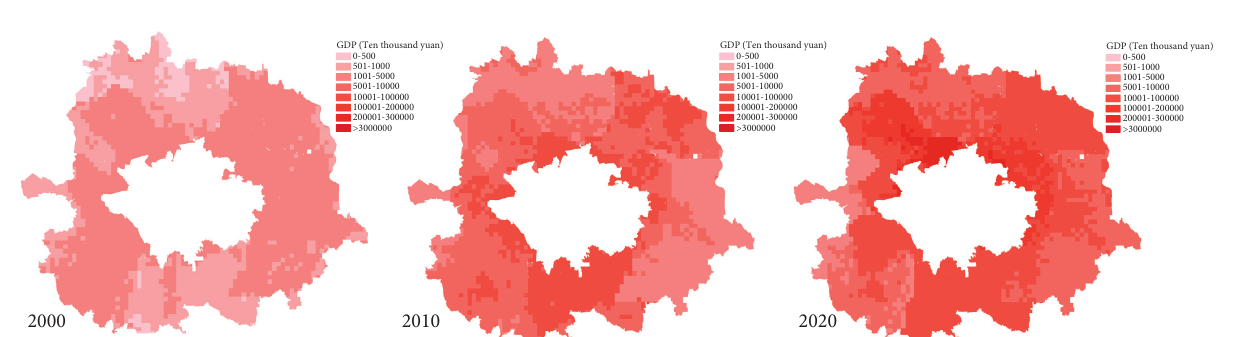
Figure 2: GDP development and change of the second green isolation area (2000–2020).